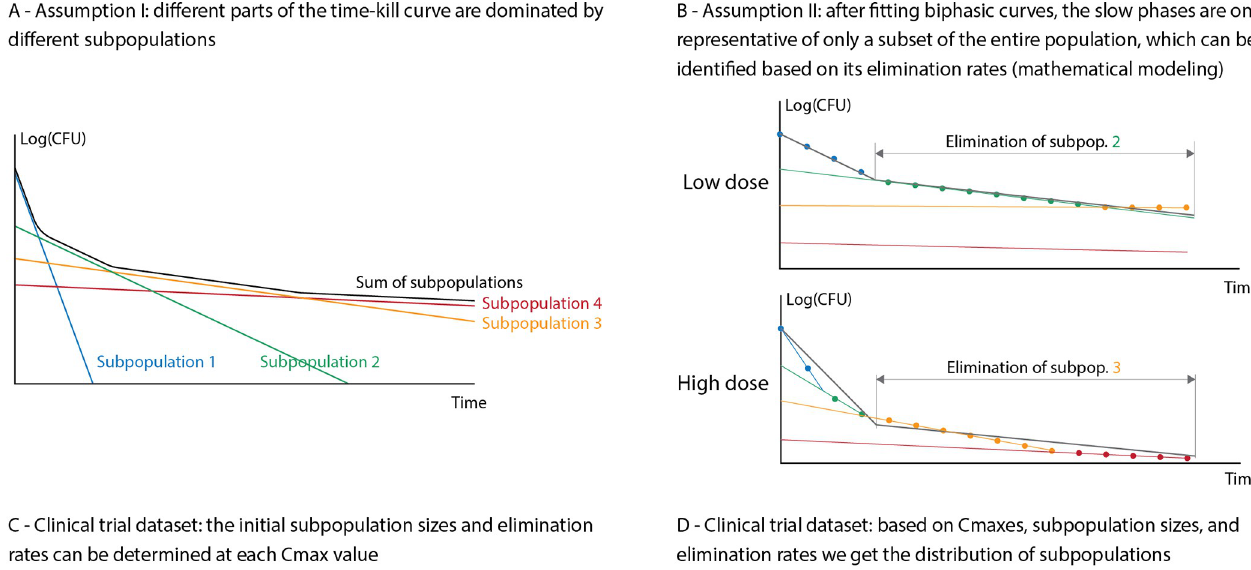
Fig 4. Estimating the sensitivity distribution of bacteria. This figure shows the method we used to estimate the sensitivity distribution of bacteria when the slowdown is caused by heteroresistance. Fig 4A (illustration) shows that different parts of the time-kill curves (bacterial count (Y-axis) over time (X-axis)) represent the decline of subpopulations with different MICs (different colours) [28]. In these cases, even after fitting biphasic curves on a multi-phasic time-kill curves ( Fig 4B (illustration)) , the slow phase will represent a subset of subpopulations which can be identified based on the decline rates at the given antibiotic concentration (Cmax or AUC in case of PK based models). Fig 4C shows the parameters used obtained from clinical trial dataset: decline rates in the slow phase and the corresponding “subpopulation sizes” at each Cmax. Fig 4D shows the value pairs from Fig 4C : the obtained sensitivity distribution and a fitted